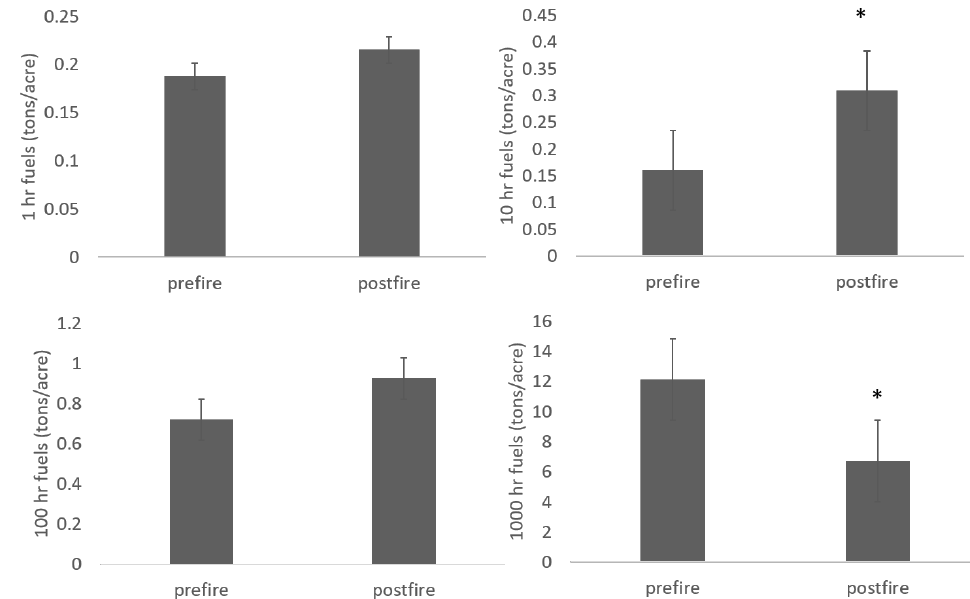
Figure 6. Mean (+1 S.E) of 1-, 10-, 100-, and 1000 h fuel loadings before and after the Coyote Fire in Guadalupe Mountains National Park, Texas. Significant differences ( p < 0.05) over the time-step according to paired t -tests are indicated with asterisks (*).